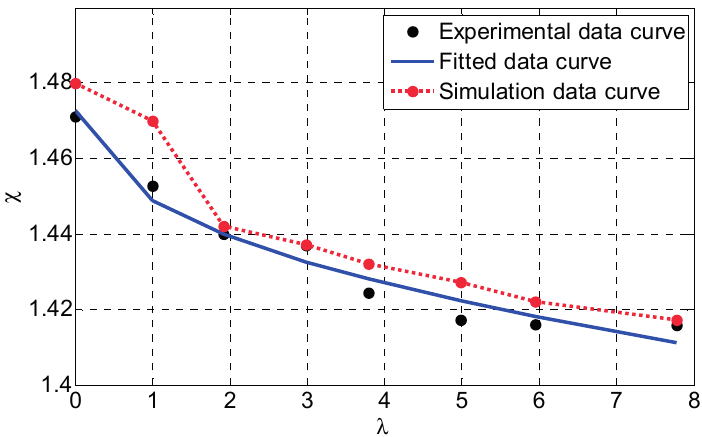
Figure 13. Experimental data curve, simulation data curve and data-fitted curve for (cid:2031) with respect to (cid:2019) , when (cid:1874) = 0.3 (cid:1865)/(cid:1871)